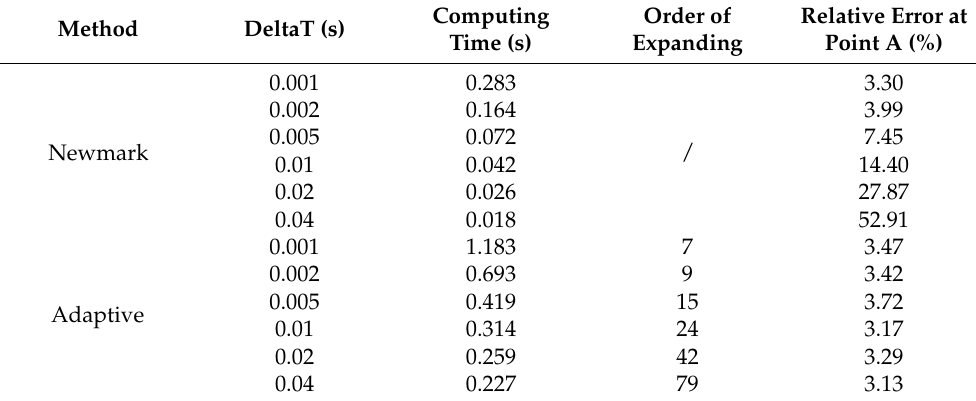
Table 2. The computing time, the order of expanding and the mean relative error at point A for two time-discretization methods.